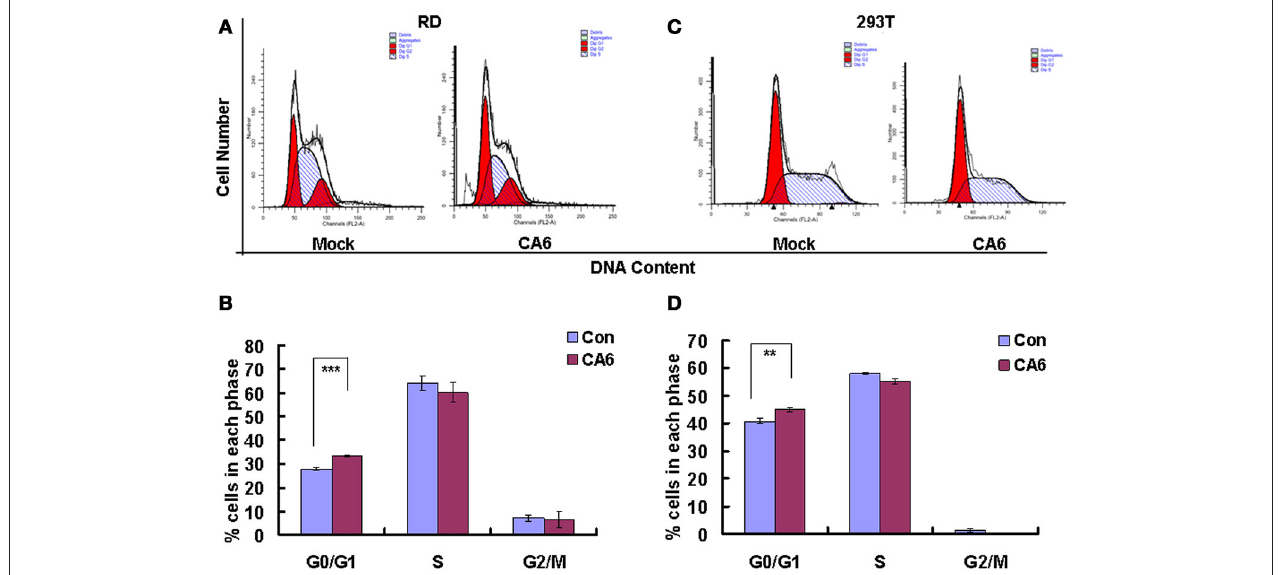
FIGURE 1 | CVA6 infection induces G0/G1-phase accumulation . (A) At 24h post-infection, RD cells infected with mock (Mock) or with CVA6 (CVA6) at an MOI of 1 were collected for analyzing cell-cycle profiles by flow cytometry. (B) The histograms were analyzed by the ModFit LT program to display the cell cycle distribution. *** P < 0.001. (C) At 48h post-infection, 293T cells infected with mock (Mock) or with CVA6 (CVA6) at an MOI of 5 were collected for analyzing cell-cycle profiles by flow cytometry. (D) The histograms indicating cell cycle distribution were analyzed by the ModFit LT program. ** P < 0.01. The results indicate the mean ± SD of three independent